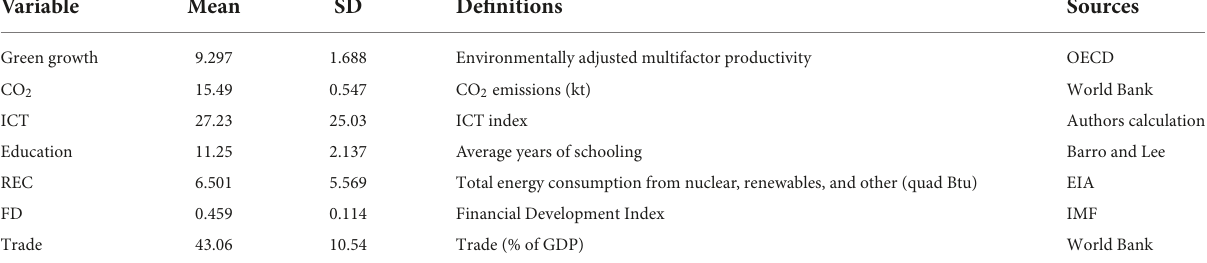
TABLE 1 Variable description and